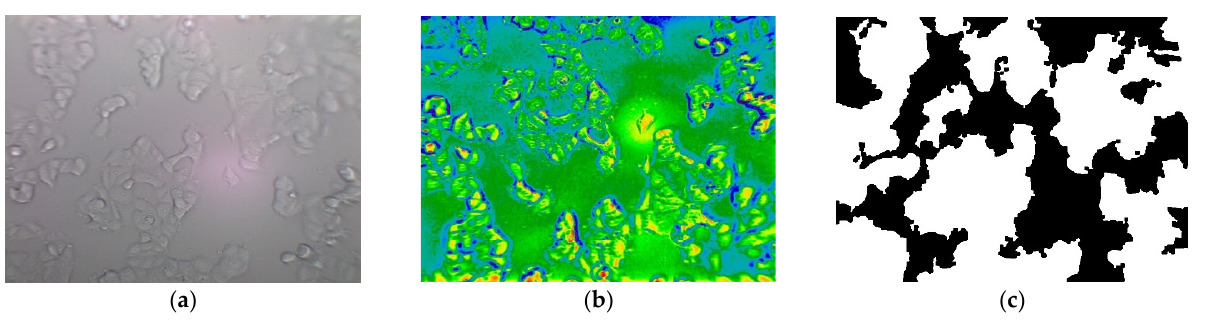
Figure 9. The segmentation of cells using the GEMA approach. ( a ) Grayscale image from Da- taset_1_CONFL in apoptosis stage; ( b ) image applied the Gabor filter set; ( c ) binarization using a closing and dilate morphological operations.